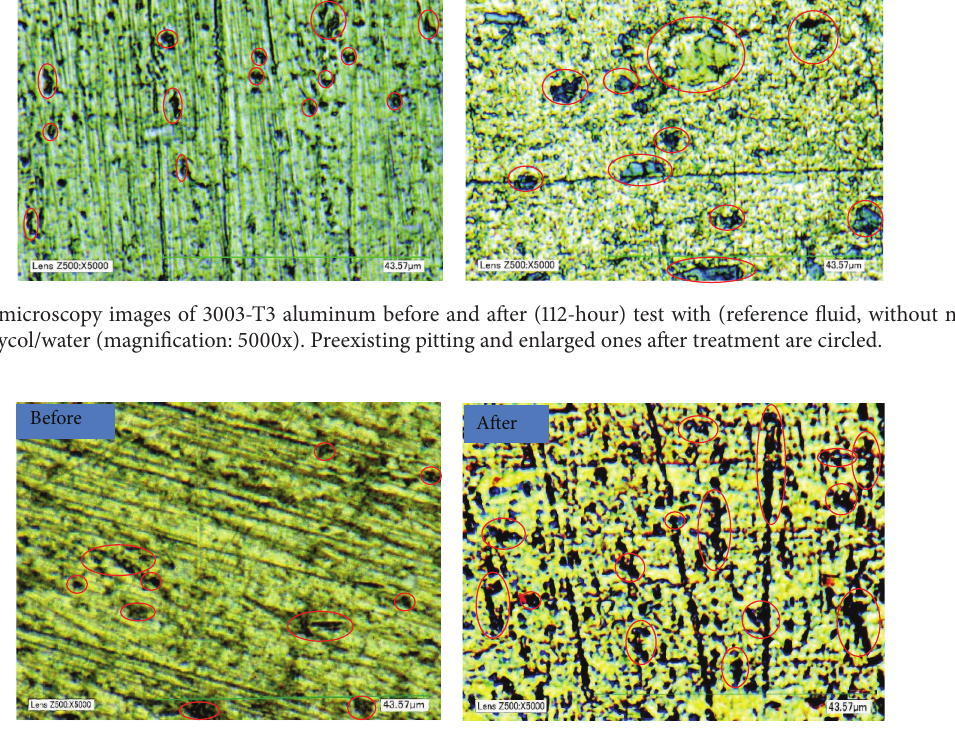
Figure 5: Optical microscopy images of 3003-T3 aluminum before and after (112-hour) test with nanofluid of 2% alumina in 50/50% ethylene glycol/water (magnification: 5000x). Preexisting pitting and enlarged ones after treatment are circled.